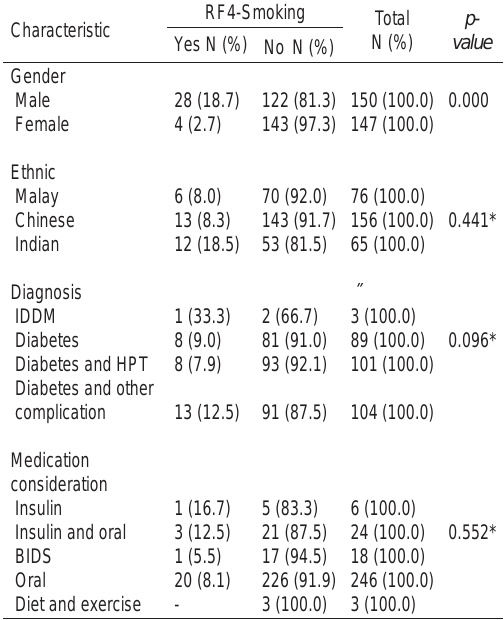
TABLE 6. Characteristic determination of RF4-Smoking